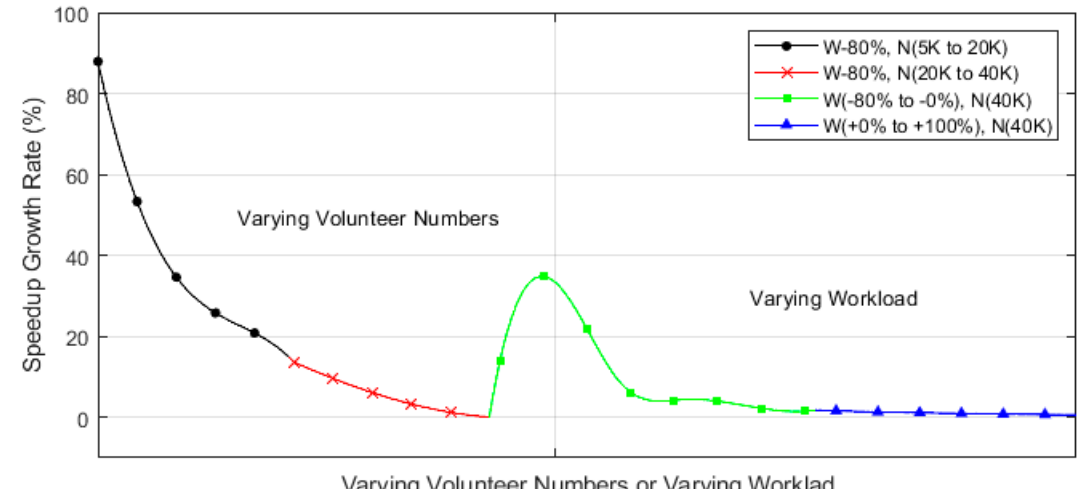
Figure 9. The speedup growth rate vs. varying volunteer numbers or varying workload.